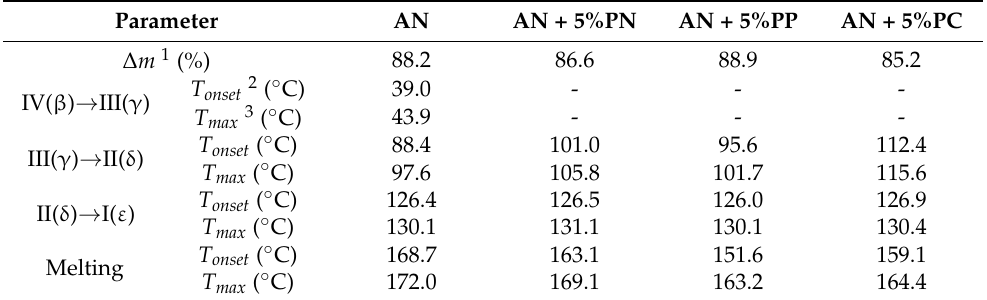
Figure 3. DTA-TG curves for AN and PSAN samples. Table 1. Results from DTA-TG curves for AN and PSAN with various potassium salts.